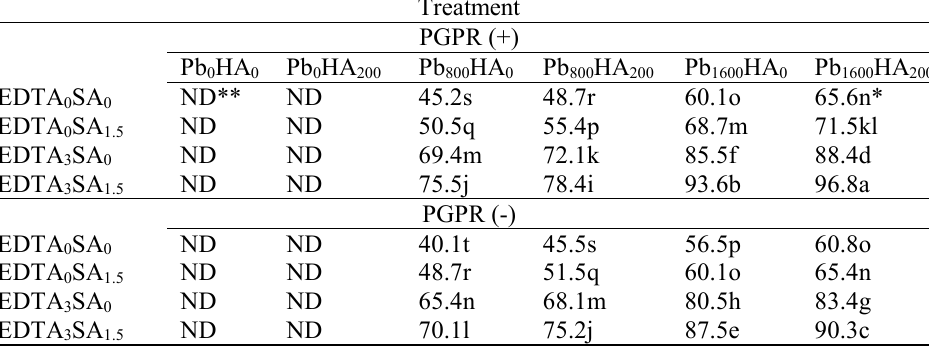
Table 2. Effect of treatments on soil Pb concentration